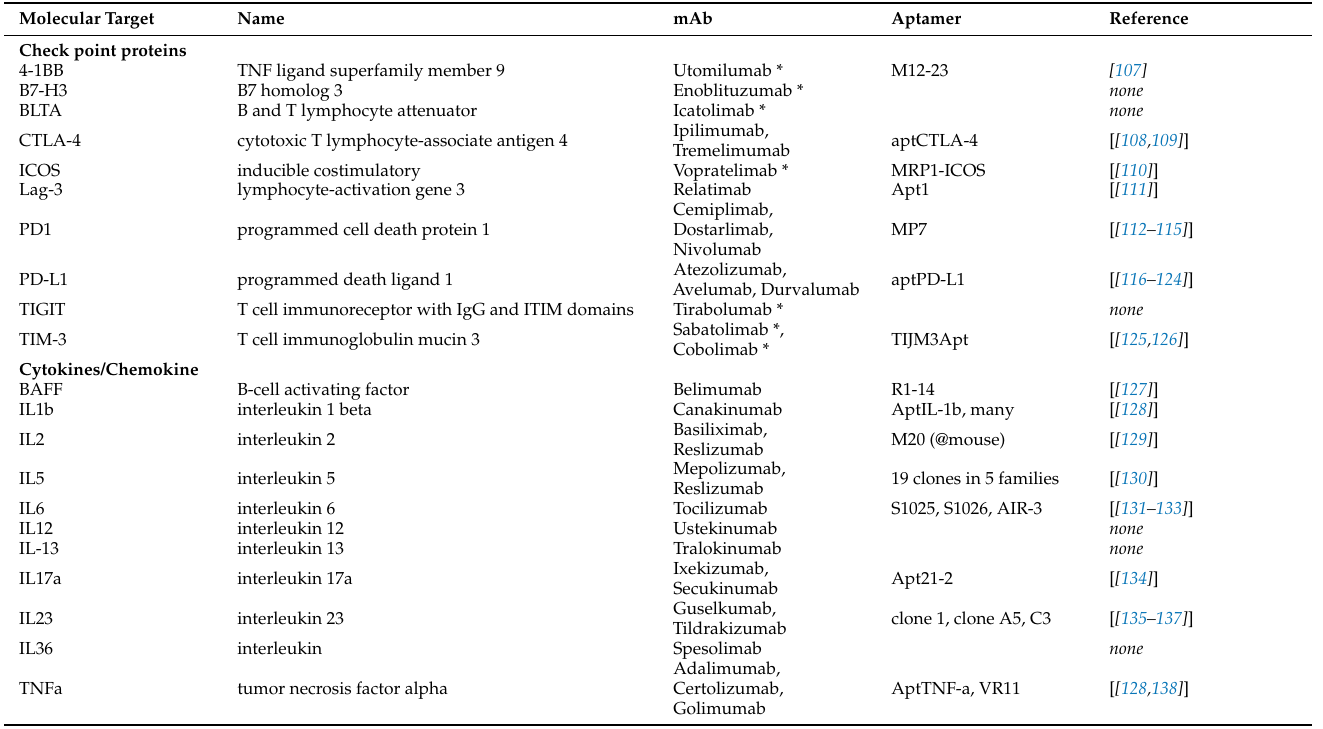
Table 3. Aptamers against common immunomodulatory molecules targeted by mAbs. The table lists some of the major molecular targets of mAbs currently FDA approved or in late-stage clinical trials (denoted by *). Aptamers reported interacting with the same targets are listed. The list is not comprehensive and only representative candidates are listed where several aptamers have been reported. The list excludes aptamers, even those in clinical trials, where there are no reports of FDA approved mAbs sharing the same target. Excellent summaries of aptamers in clinical trials can be found in [101–103]. Information from several excellent reviews [1,10,104–106] and an original literature search was used to gather the information shown